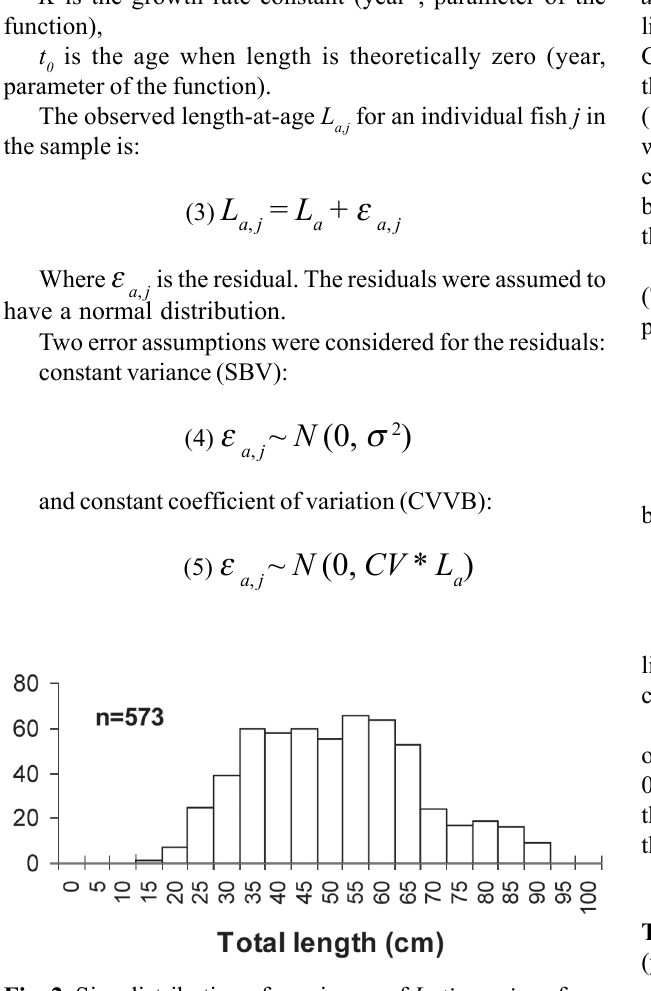
Fig. 2. Size distribution of specimens of Lutjanus jocu from Abrolhos Bank, captured by the commercial fishing fleet.